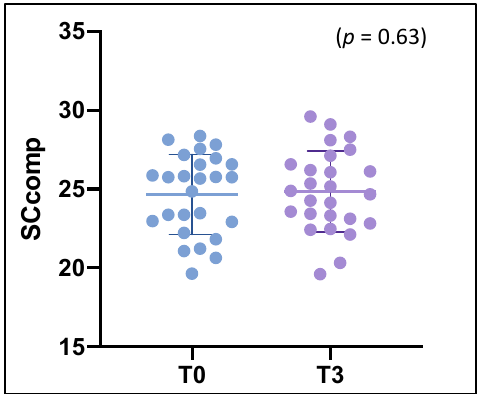
Figure 2. Comparison and evolution of SCcomp between baseline (T0) and follow-up (T3). SCcomp = social cognition composite score.